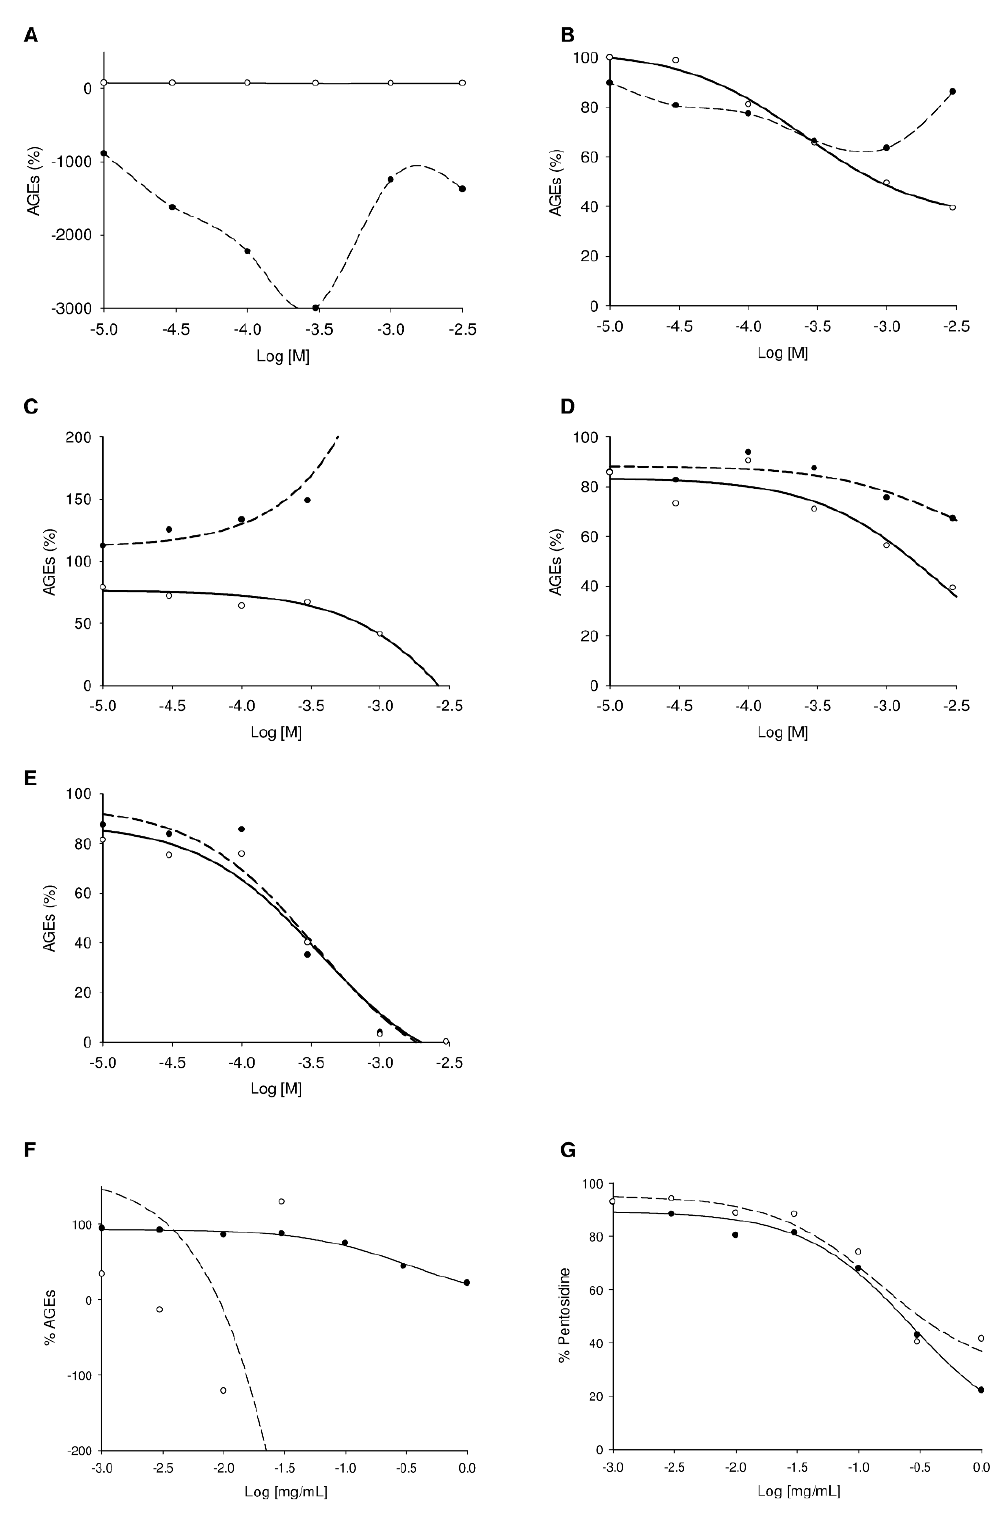
Figure 5. Dose-effect curves for vesperlysines-like AGE (dotted) and pentosidine-like AGE (bold) formation in the presence of umbelliferone 20 ( A ), caffeic acid 18 ( B ), emetine 19 ( C ) or aminoguanidine ( D ) or quercetin 10 ( E ) as well as dose-effect curves for vesperlysines-like AGE ( F ) and pentosidine-like AGE ( G ) formation in the presence of Mammea neurophylla fruit methanolic extract with (dotted) or without (bold) umbelliferone 20 (10%